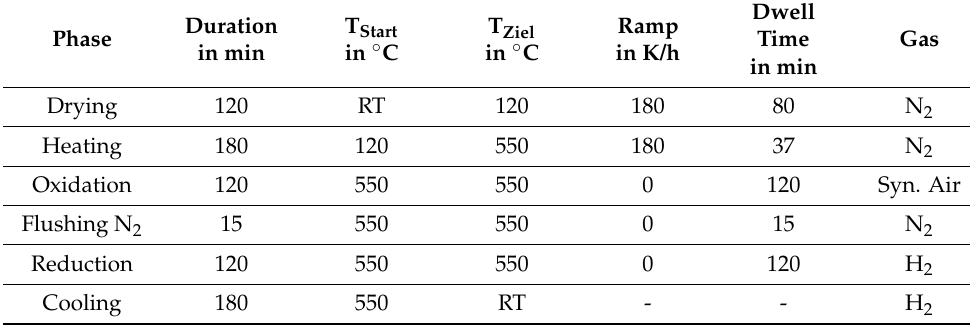
Table 3. Standard pretreatment for the catalytic test